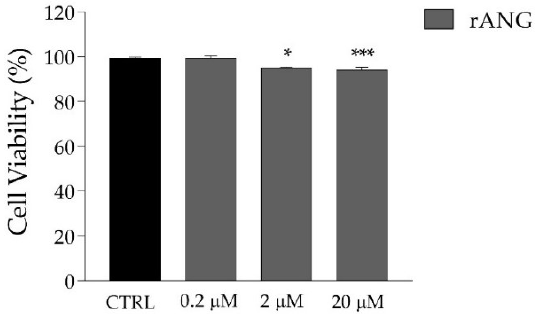
Figure 5 . HaCaT cells viability measured after the treatment of cells for 24 h with increasing doses of rANG. Statistical analyses were carried out by using GraphPad Prism. Values are the means ± SEM of biological replicates (* p < 0.05, *** p < 0.001) compared to the respective controls (one-way ANOVA, followed by Bonferroni’s post-test).